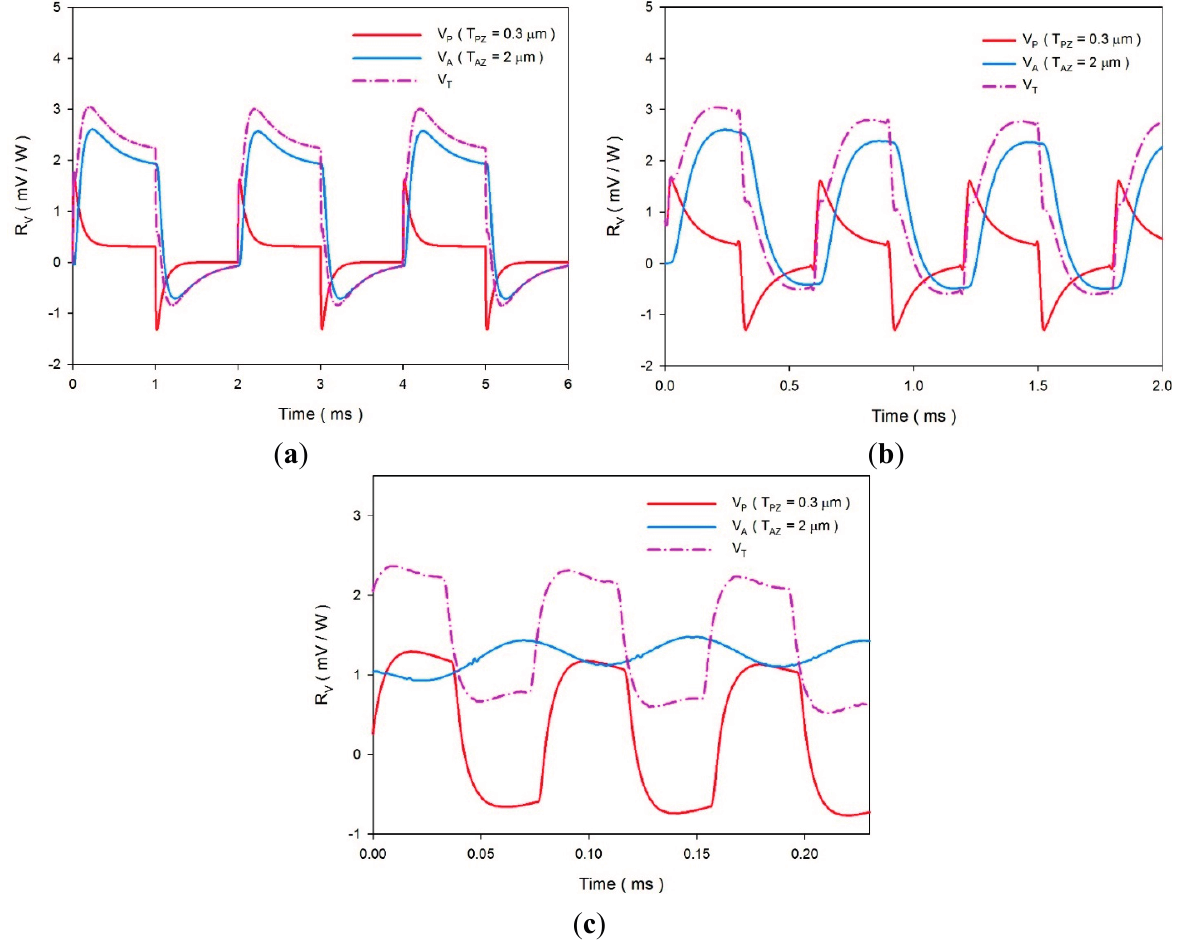
Figure 14. Voltage responsivities of the multi-frequency band pyroelectric device with T PZ = 0.3 μ m and T AZ = 2 μ m under the incident irradiation power modulated with various chopping frequencies of about ( a ) 10,000 Hz; ( b ) 33,000 Hz and ( c ) 250,000